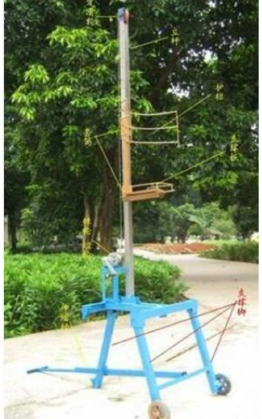
Figure 2. Banana assist picking